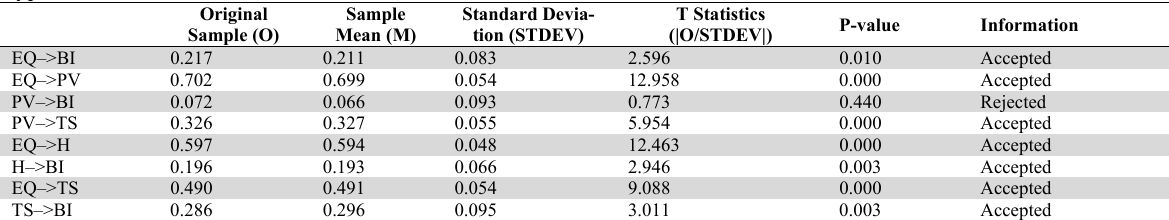
Hypothesis Test Results of Direct